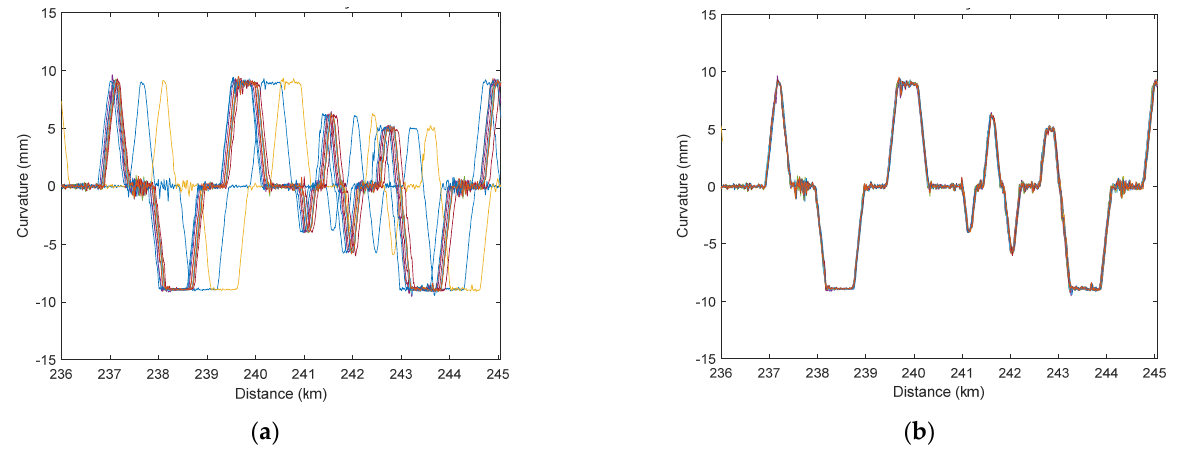
Figure 7. Curvature before ( a ) and after ( b ) synchronization.